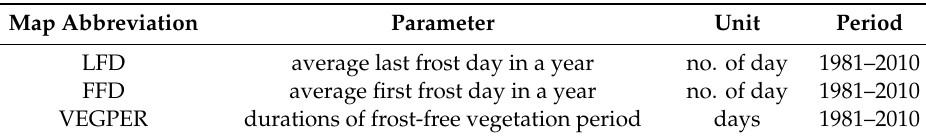
Table 3. Resulting map of first and last freezing day of the